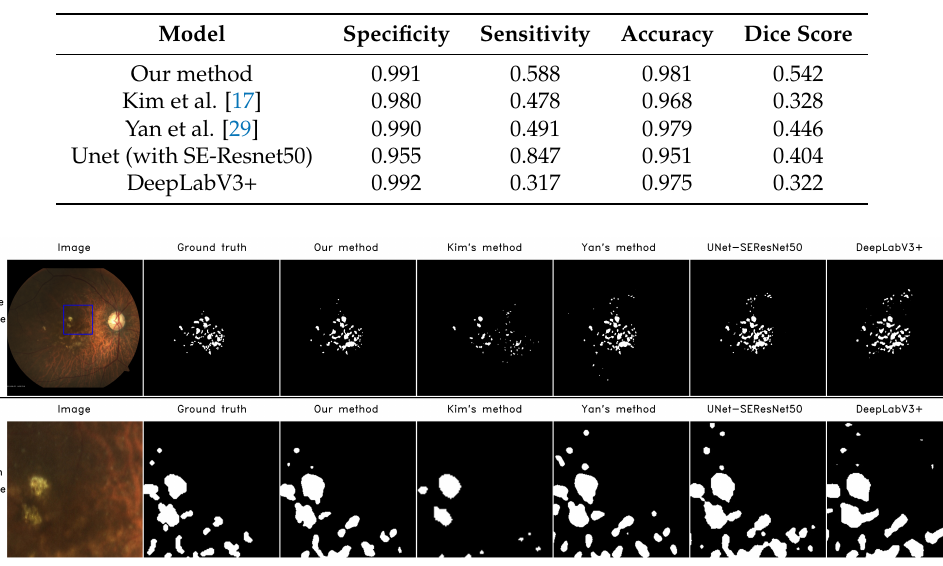
Table 4. The comparison of drusen segmentation methods on STARE dataset.